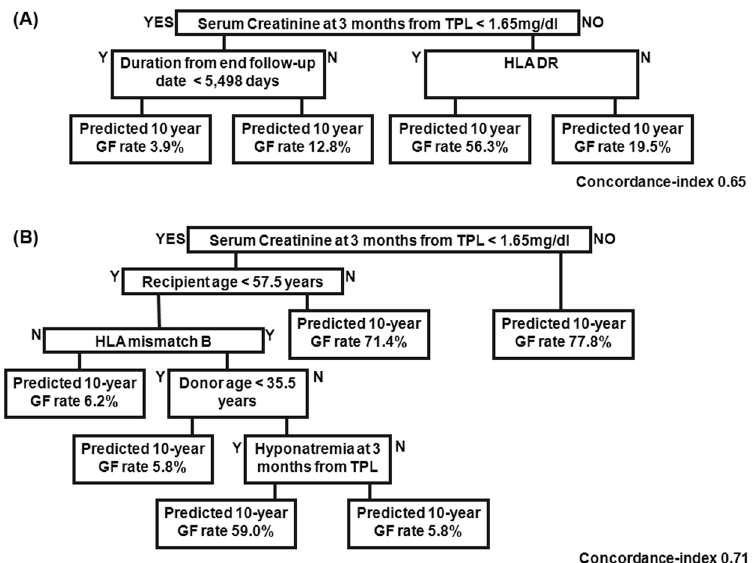
Figure 2. The 10-year graft failure prediction using a decision tree model. Decision tree for the training, test and validation data set, after stratified sampling, with ‘Y’ indicating a positive conclusion and ‘N’ a negative conclusion. The 10-year graft failure rate is reported as a percentage. ( A ) Model setting 1: Use overall attributes with multiple imputation. ( B ) Model setting 2: Use attributes except DSA, with/without imputation